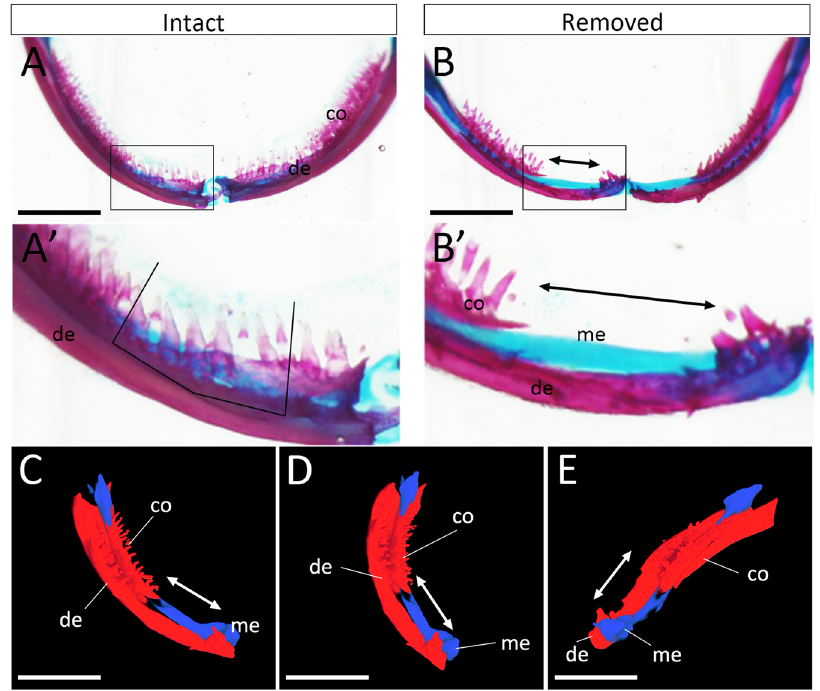
Figure 3. Dentectomy of the axolotl mandible. ( A,B ) Skeletal preparation stained with Alcian blue and Alizarin red. ( A, A’ ) Axolotl mandible before dentectomy. A’ is the higher magnification of the boxed area in A. Lines indicate the approximate incision sites. ( B, B’ ) Axolotl mandible just after dentectomy. B’ is the higher magnification of the boxed area in B. Arrows in B and B’ indicate the dentectomized area. co = coronoid. de = dentary. me = Meckel’s cartilage. Data are representative of 21 samples. ( C–E ) CoMBI imaging of the dentectomized mandible. Arrows indicate the dentectomized region. Scale bars = 500 μ m. Data are representative of 3